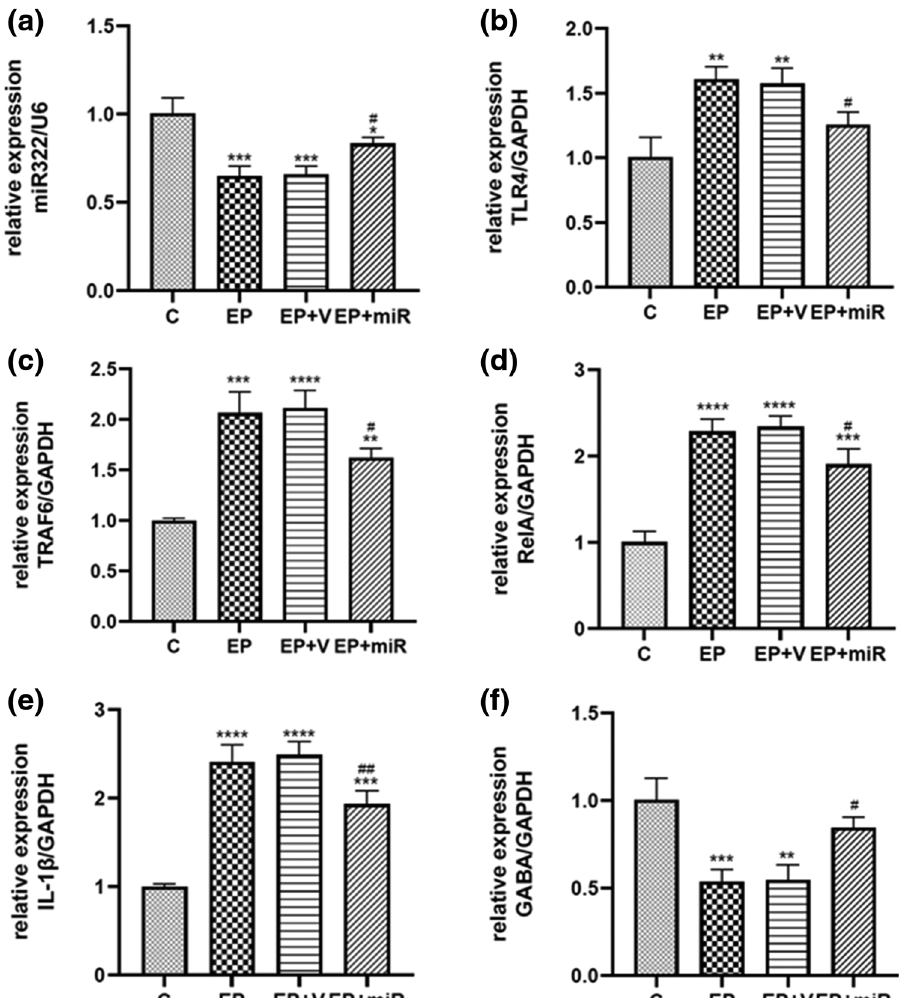
Figure 3: qRT - PCR analysis of the in fl ammatory markers and miR - 322 - 5p. Notes: ( a ) The miR - 322 - 5p - treated rats showed a higher miR - 322 - 5p level than EP + V group. ( b ) TLR4 levels decreased after miR - 322 - 5p injection. ( c ) TRAF6 levels decreased after miR - 322 - 5p injection. ( d ) RelA levels decreased after miR - 322 - 5p injection. ( e ) IL - 1 β levels decreased after miR - 322 - 5p injection. ( f ) GABA levels increased after miR - 322 - 5p injection. * p < 0.05, ** p < 0.01, *** p < 0.001, **** p < 0.0001 compared with control; # p < 0.05, ## p < 0.01 compared with EP + V group. Abbreviations: C: control, EP: epilepsy, EP + V: epilepsy + vehicle, EP + miR: epilepsy + miR - 322 - 5p intervention